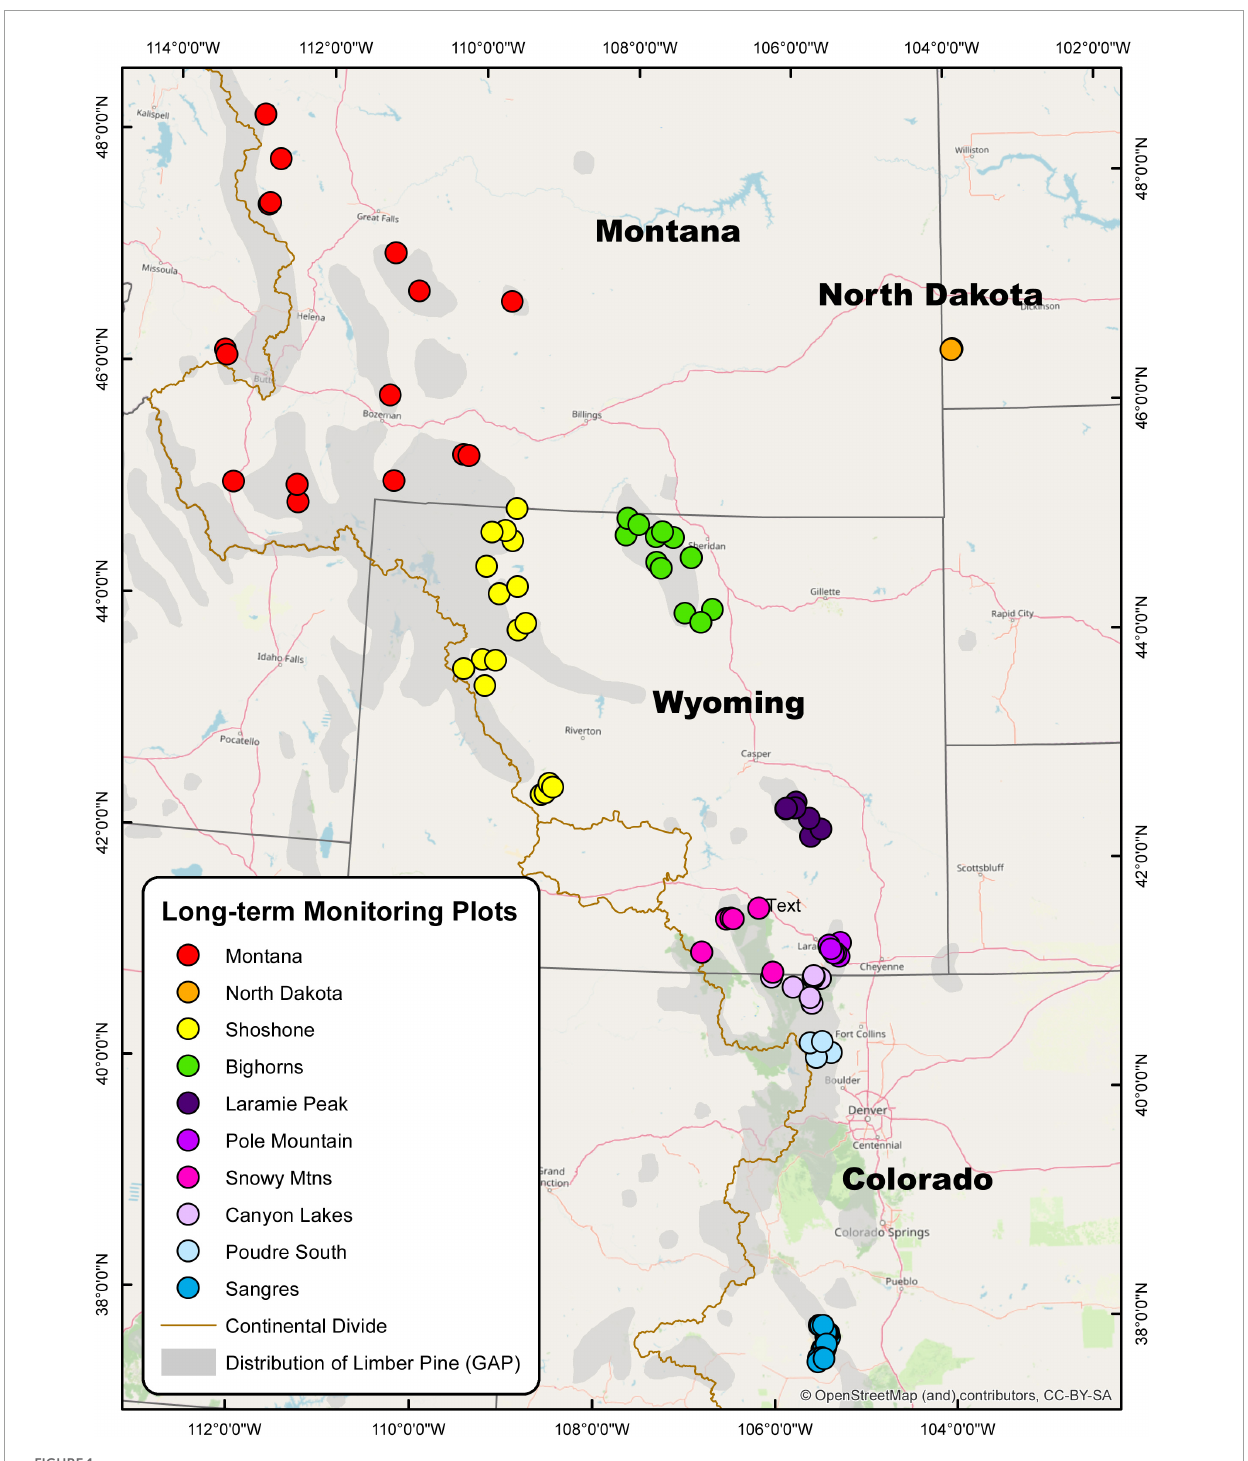
FIGURE1 Map of 106 long-term limber pine health monitoring plots measured three times between 2004–2007 and 2016–2017 in the U.S. Rocky Mountains. The 10 study areas are denoted by color and include Montana (16), North Dakota (2), Shoshone (17), Bighorns (12), Laramie Peak (7), Pole Mountain (8), Snowy Mountains (7), Canyon Lakes (8), Poudre South (4), and Sangre de Cristos (25). Limber pine distribution (denoted in gray) was gathered from the USGS Gap Analysis Project (GAP).